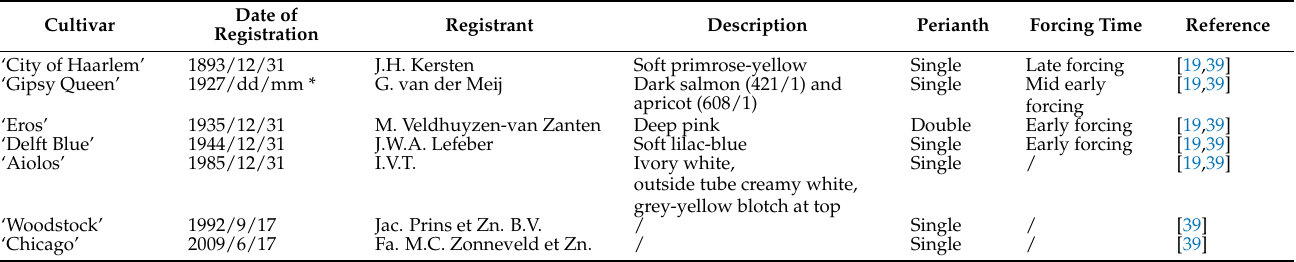
Table 5. Information of the registered Hyacinthus cultivars from KAVB.